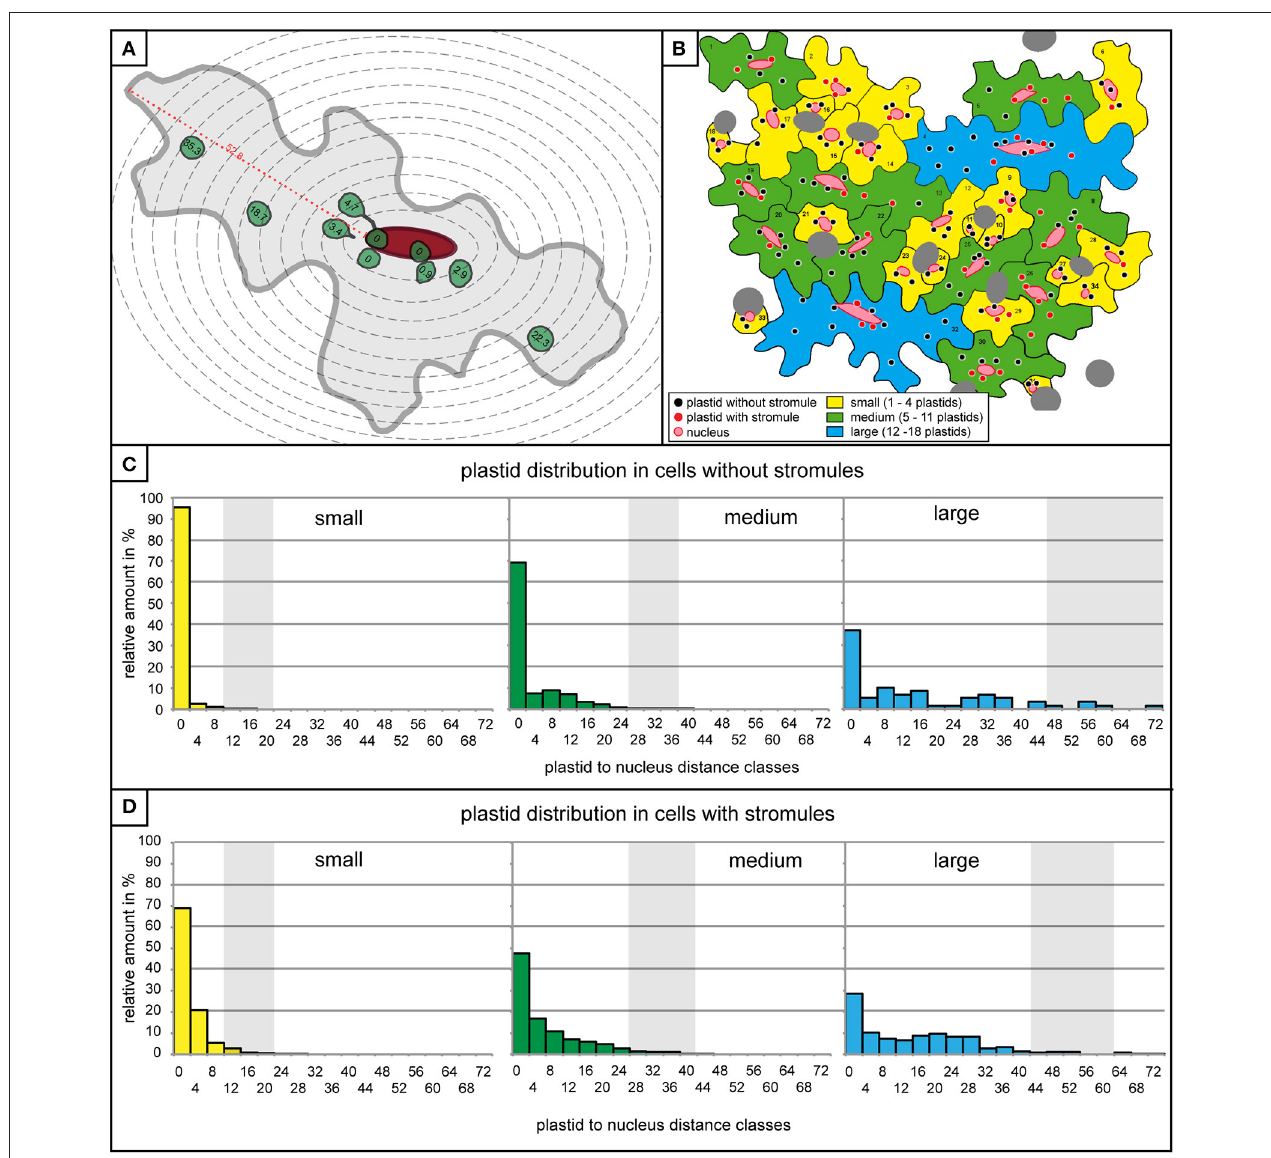
FIGURE 4 | Plastids distribution is similar in cells with and without stromules. (A) A graphic representation of a medium sized cell with 4 µ m zone boundaries outlined with dotted gray lines, the nucleus in red, and the plastids with and without stromules are in green. Distance of all plastids to the nucleus (in µ m) is written within the plastid. The maximum distance possible between a plastid and the nucleus (i.e., the longest distance between the nucleus and the cell border) is highlighted with a red dotted line and marked with the distance measurement for this particular cell. (B) A graphic representation of the microscopy picture found in Figures 1D , 2B , demonstrating the distribution of plastids in cells with and without stromules in the different cell size categories. (C,D) Histograms exhibiting the number of plastids within each 4 µ m zone (x-axis) in small (yellow), medium (green) and large (blue) cells lacking stromules (C) and in cells with stromules (D) . Thick vertical lines (light gray) represent the average maximum distance a plastid can be from the nucleus. Average maximum distance values were generated by measuring the maximum distance between the nucleus and cell border in each cell and averaging these values (example measurement highlighted by a red dotted line in A ). The greatest distance possible between the nucleus and the plastid depends on cell size, but also nucleus position within the